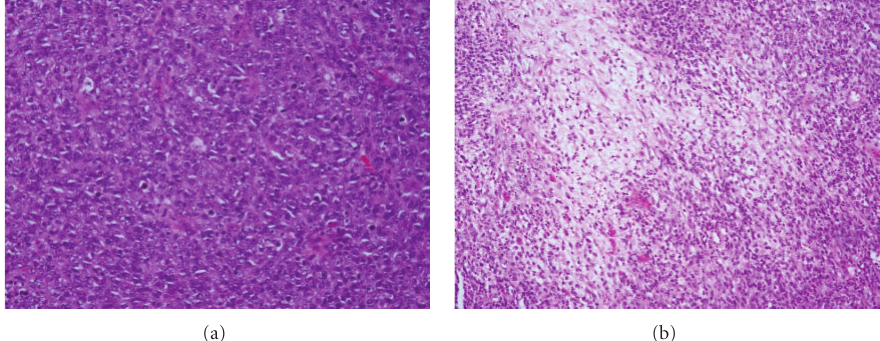
Figure 2: (a) Microscopic view of densely cellular area comprised of pleomorphic round and spindled cells (hematoxylin and eosin, × 200). (b) Paucicellular area with myxoid matrix (hematoxylin and eosin, × 200).